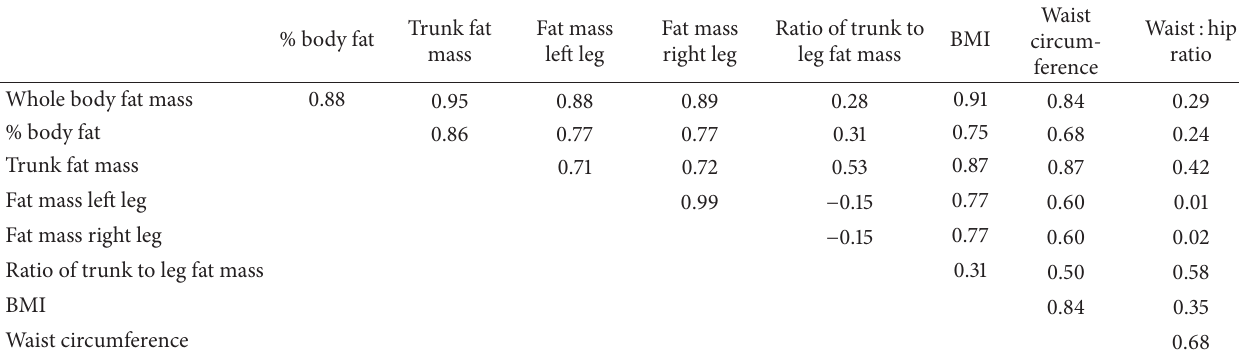
Table 1: Correlation matrix of baseline DXA and anthropometric measures among non-cases ( 𝑁 = 10,457) a .